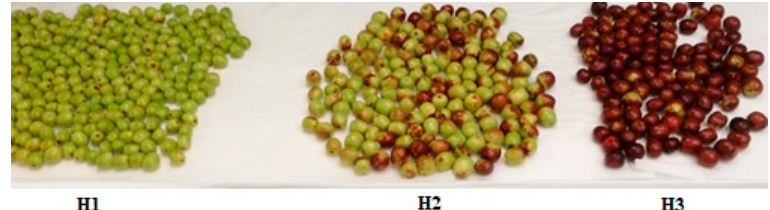
Figure 6. Division of harvesting stages (H1 to H3) according to appearance of jujube fruit. Harvesting stages of jujube fruits were characterized by di ff erent colors and sizes: H1, green stages; H2, yellow and green stage with mahogany-colored spots; H3, all-red ripening